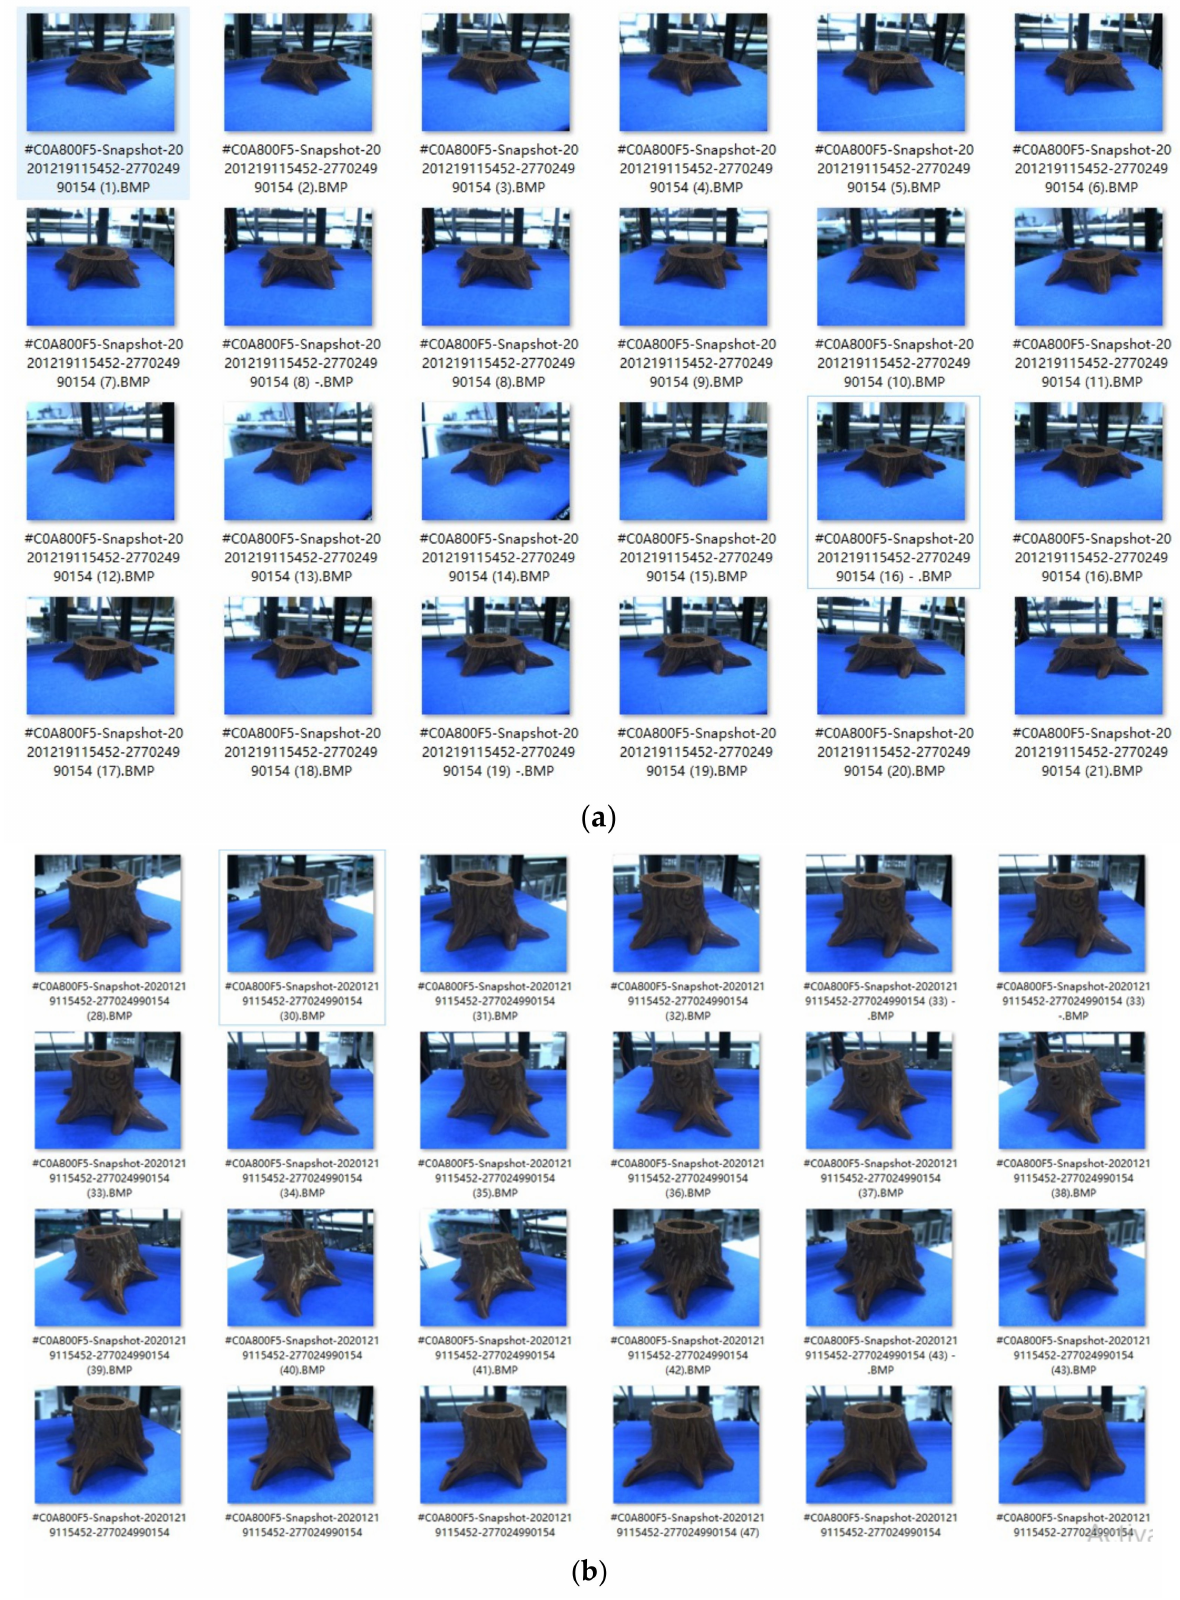
Figure 11. Captured images of 3D printing process. ( a ) Photo Gallery 1; ( b ) Photo Gallery